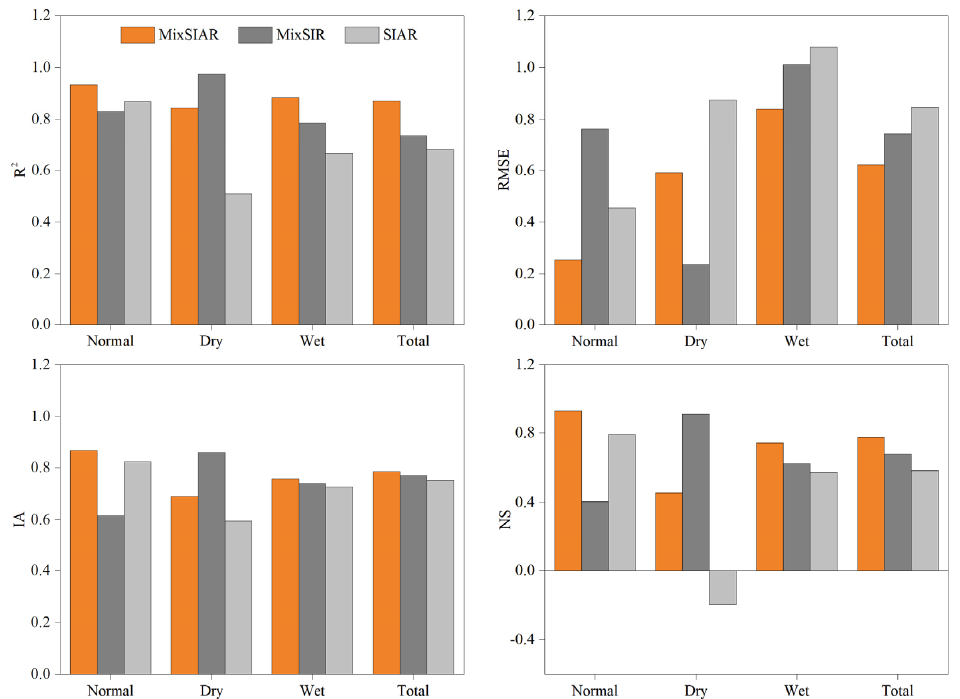
Figure 6. Mixing model performance indicators in water source partitioning under the normal, dry, and wet conditions and their combination (total). and wet conditions and their combination